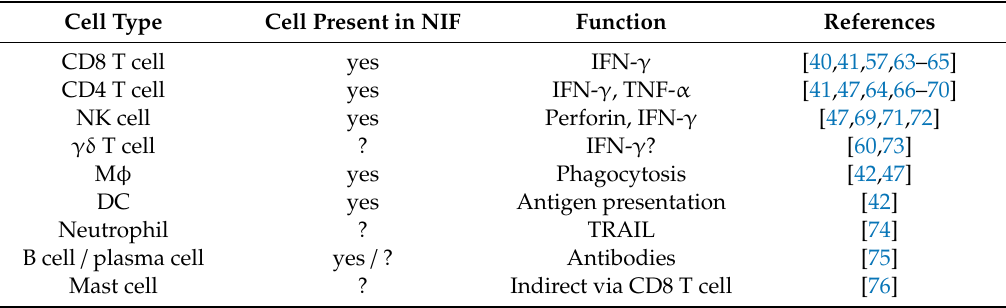
Table 1. Immune cells and their antiviral function in MCMV